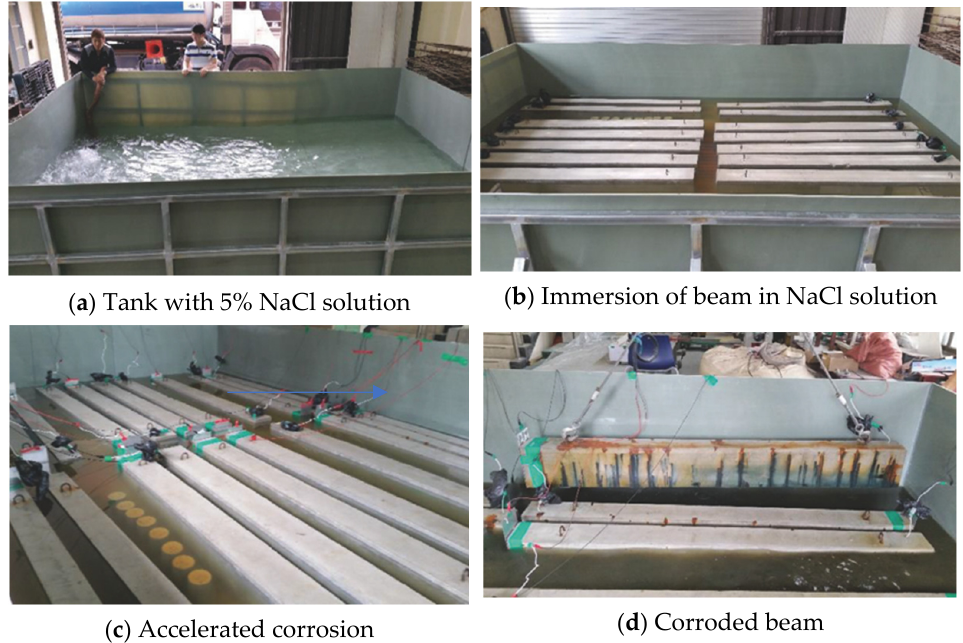
Figure 6. Accelerated corrosion setup. Adapted from [83].